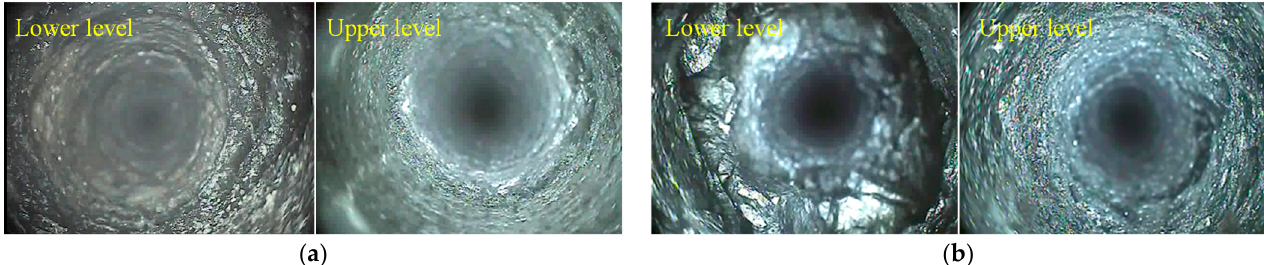
Figure 7. Borehole camera detection. ( a ) Borehole A; ( b ) Borehole B.